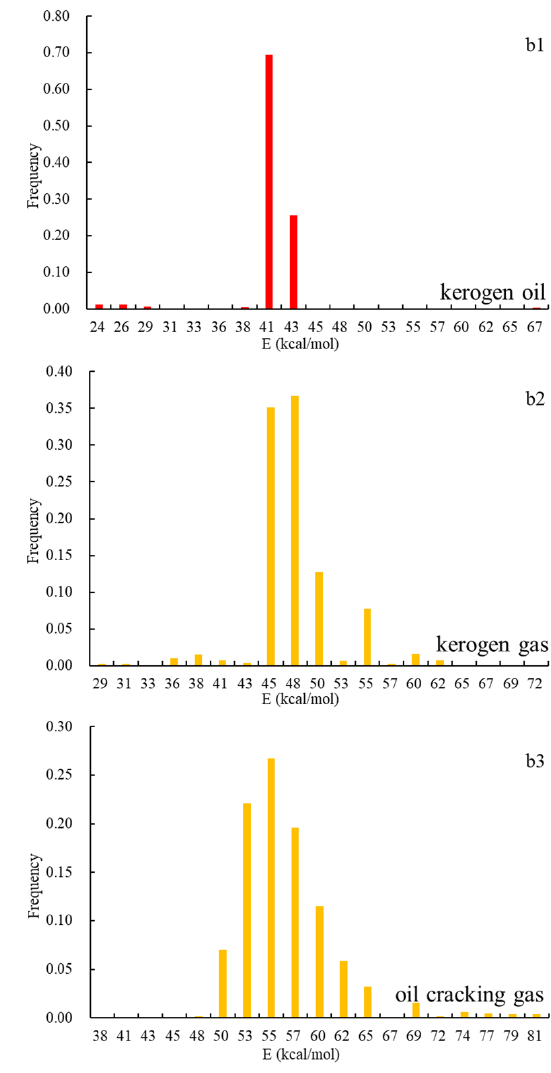
Figure 10. Activation energy distribution of kerogen(( a1 – a3 ). type II 1 ; ( b1 – b3 ). type II 2 ).